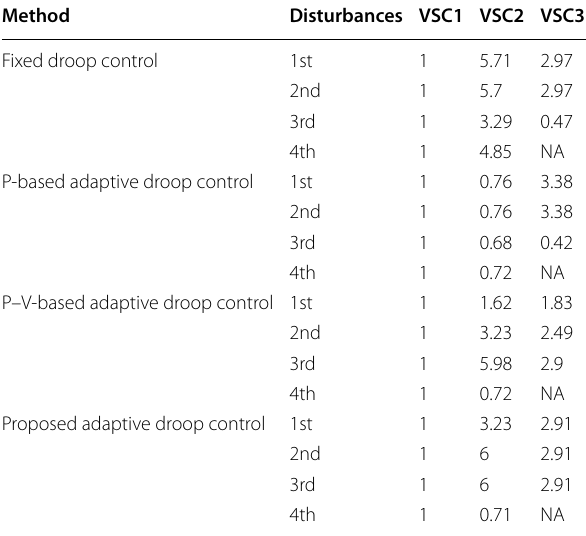
Table 3 Power sharing ratios amongst onshore AC